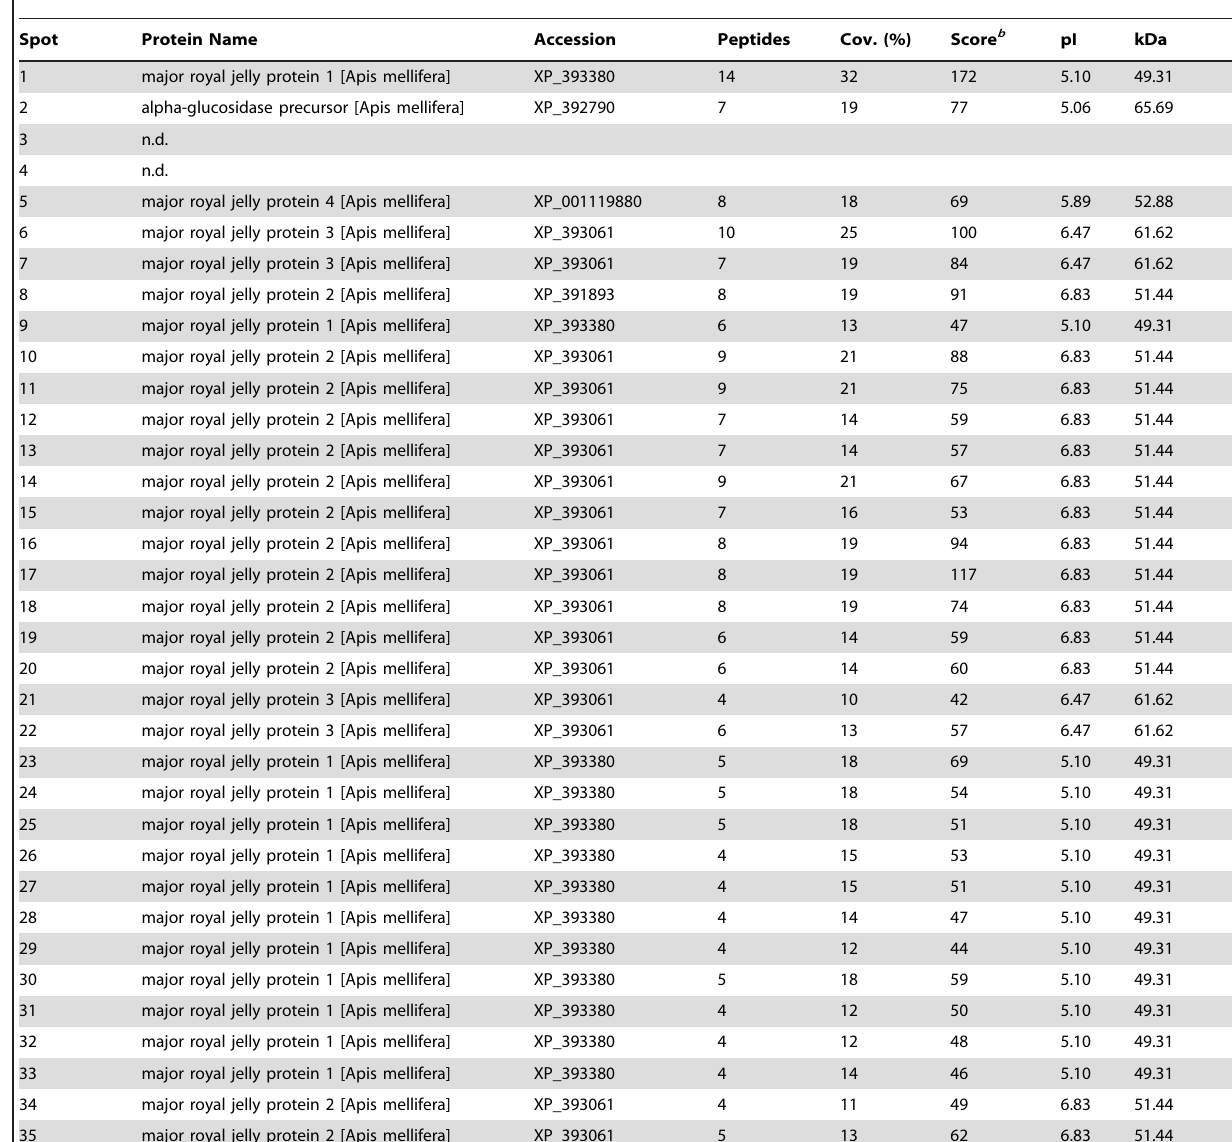
Table 4. Protein identification in the honey chestnut MT1 extract a